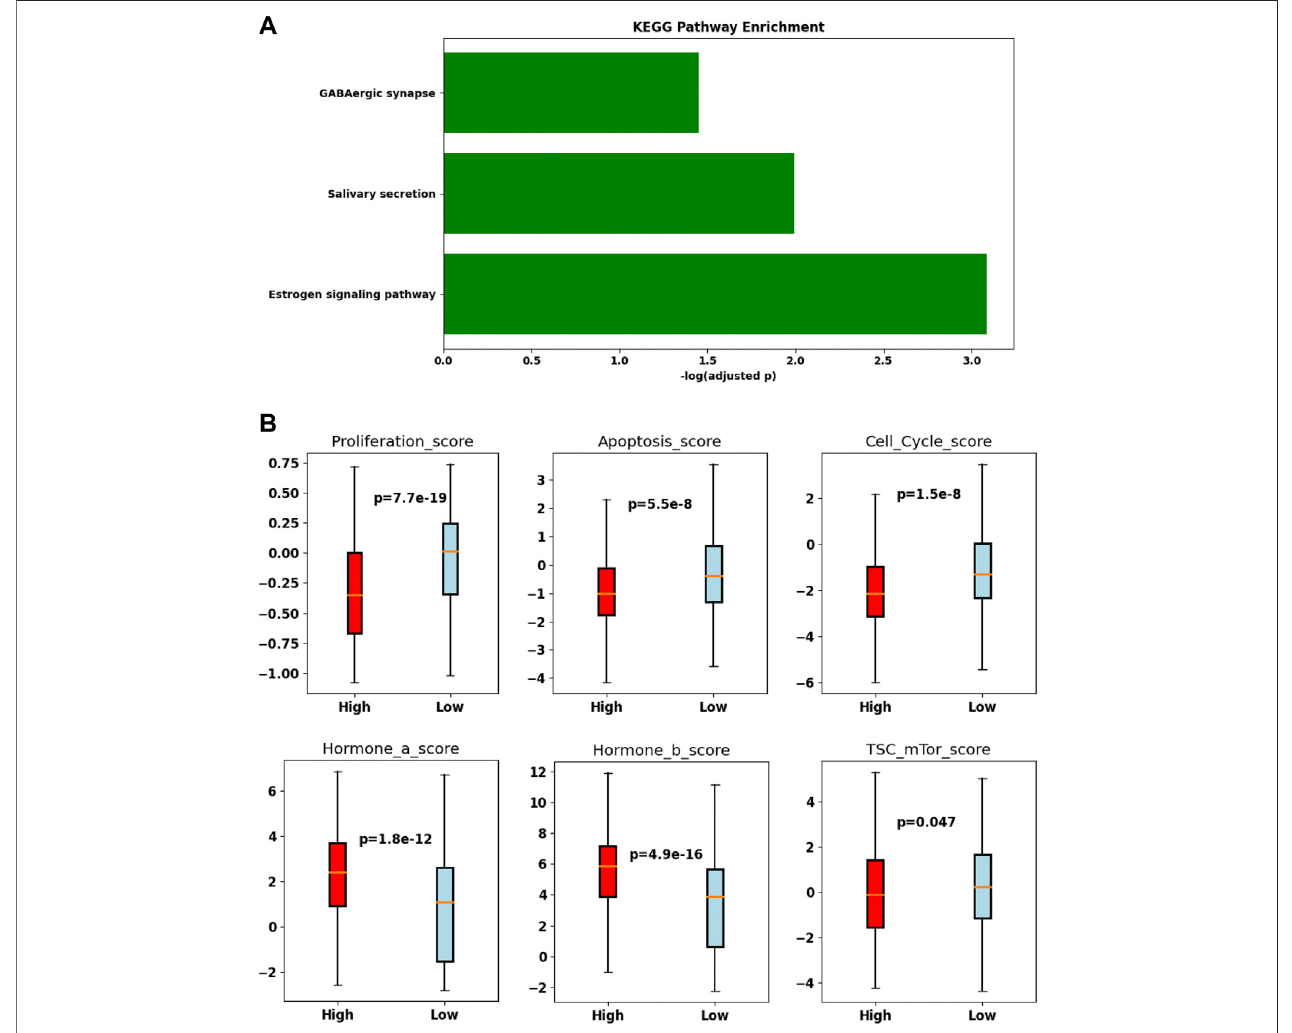
FIGURE6| DifferenceintheTRIM45-groupandtheTRIM45-lowgroup. (A) barplotoftheenrichedKyotoEncyclopediaofGenesandGenomes(KEGG)pathway. (B) Boxplot of proliferation score, apoptosis score, cell cycle score, hormone a score, hormone b score, TSC mTor score.